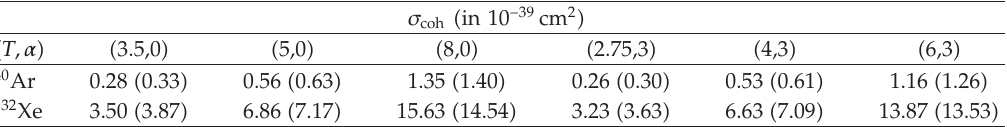
Table 5: Coherent neutrino nucleus cross sections calculated by (cid:3) 5.4 (cid:4) and by the QRPA approach (cid:3) numbers in parenthesis (cid:4) for 40 Ar and 132 Xe targets. The supernova neutrino spectra described by a two parameter Fermi-Dirac distribution with α (cid:8) 0 and 3 for various temperatures T (cid:3) MeV (cid:4) . σ coh (cid:3) in 10 − 39 cm 2